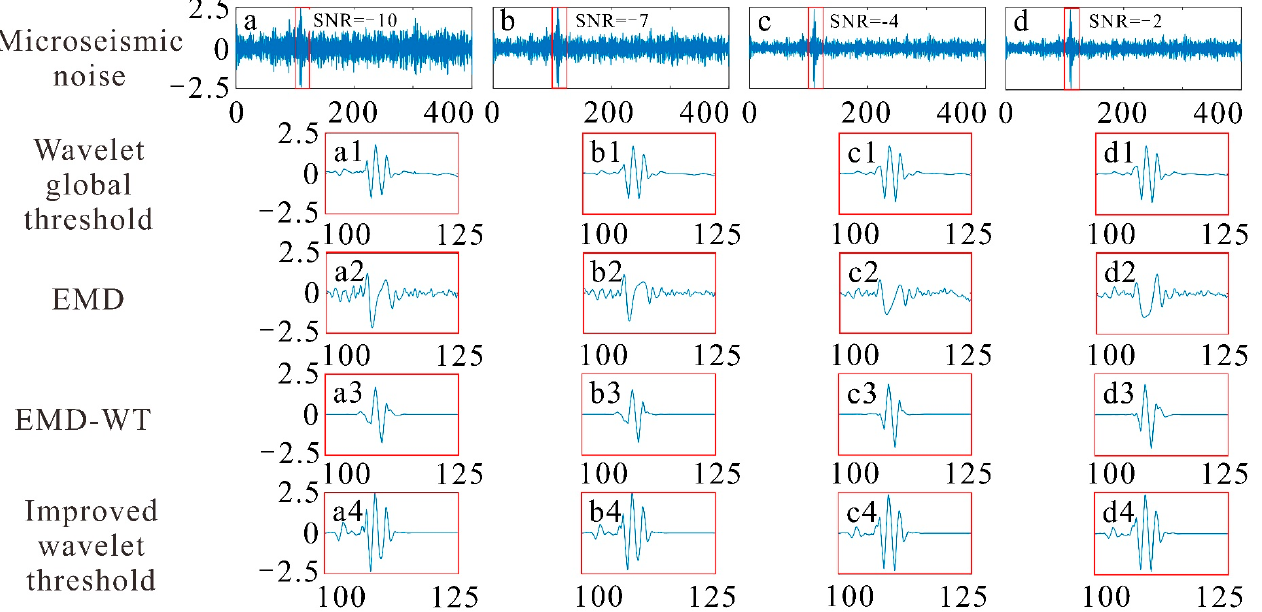
Figure 8. Comparison of denoised synthesized microseismic signals with different SNRs: ( a ) micro- seismic noise of SNR = − 10, ( b ) microseismic noise of SNR = − 7, ( c ) microseismic noise of SNR = − 4, ( d ) microseismic noise of SNR = − 2, ( a1 , b1 , c1 , d1 ) Wavelet global threshold denoising signal, ( a2 , b2 , c2 , d2 ) EMD denoising signal, ( a3 , b3 , c3 , d3 ) EMD-WT denoising signal, ( a4 , b4 , c4 , d4 ) im- proved wavelet threshold denoising signal.